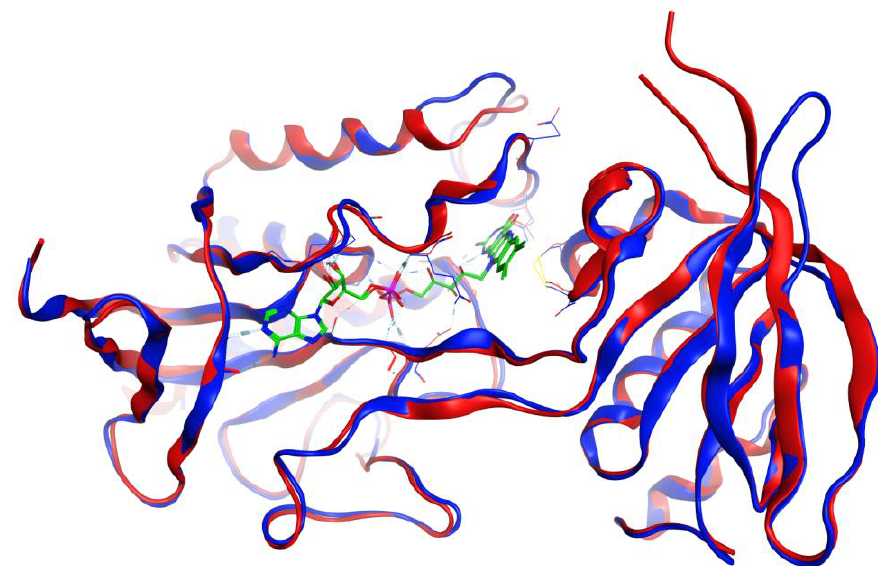
Figure 4. Overlay of the protein structures of Brucella melitensis TxR, PDB 4JNQ [24] (red ribbon), and the homology model of Trichomonas vaginalis TxR (blue ribbon). The co-crystallized ligand is shown as a wireframe structure.